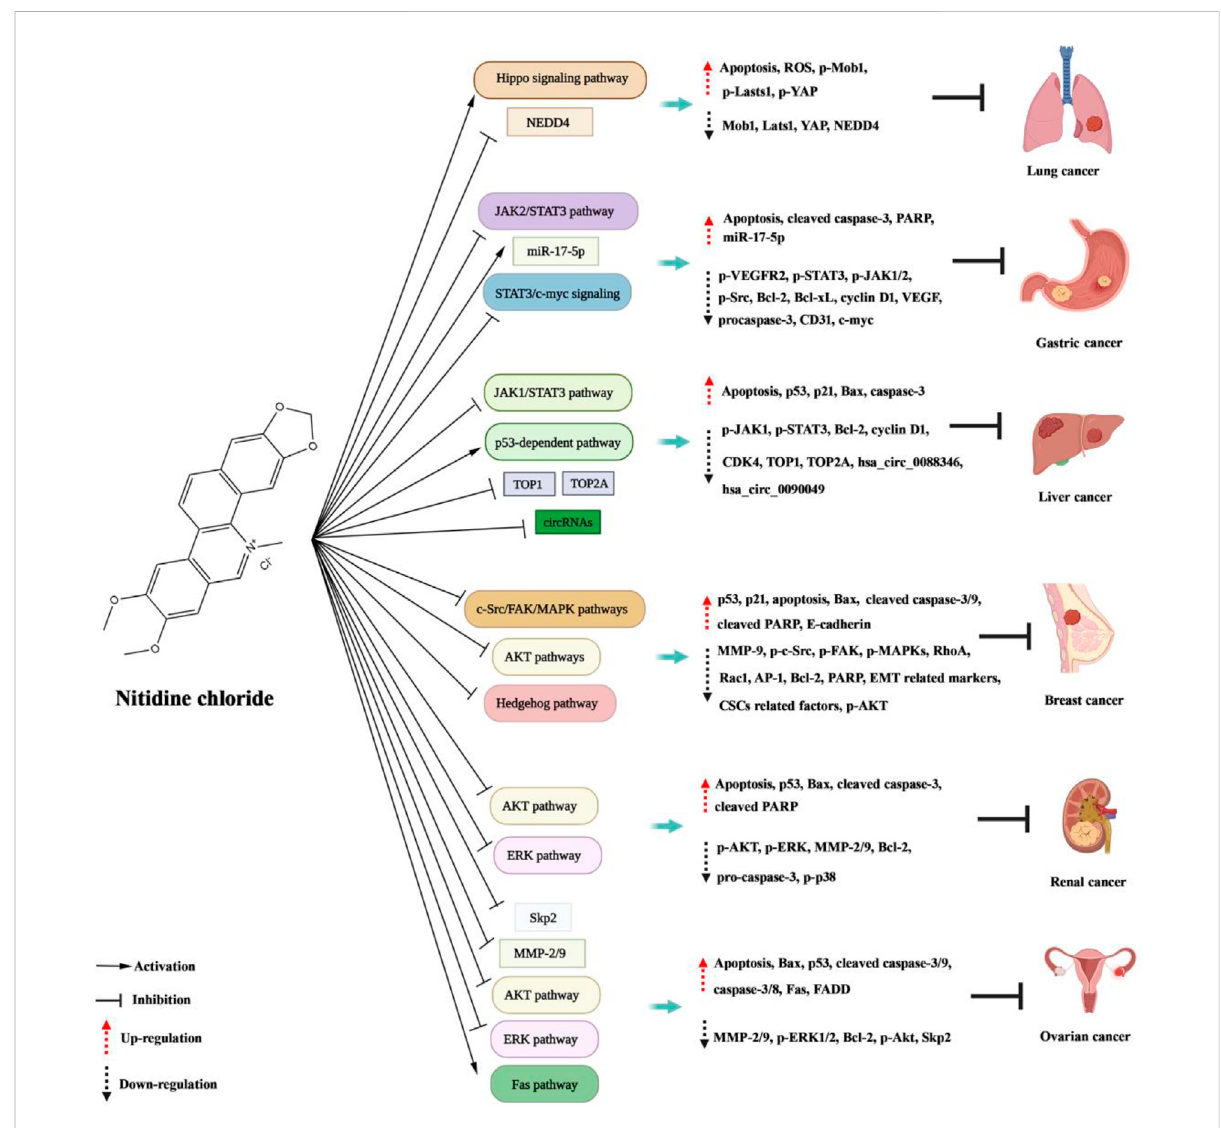
FIGURE 2 Molecular mechanisms of nitidine chloride against